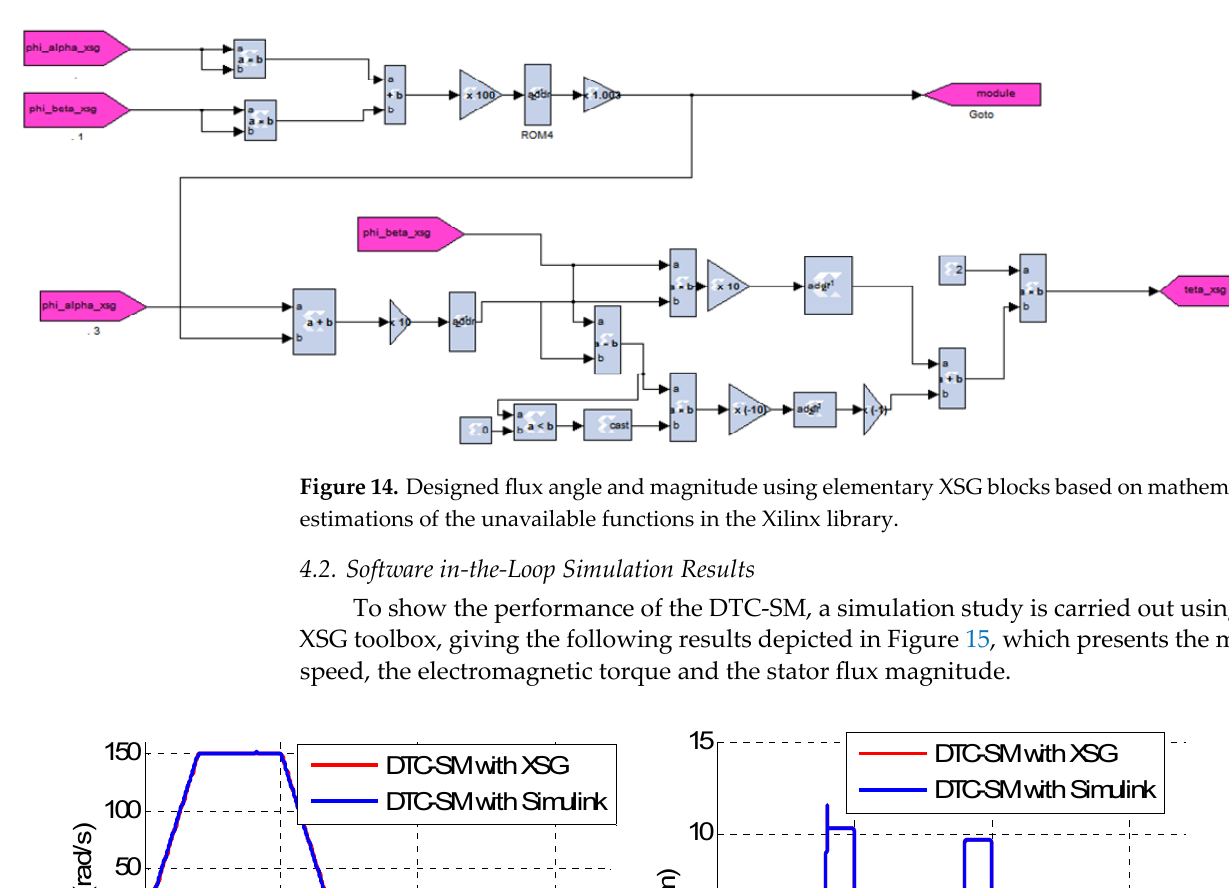
15 of 19 Figure 13. XSG modeling of the coordinate transformation (d,q) to ( , ) α β using ROM blocks.